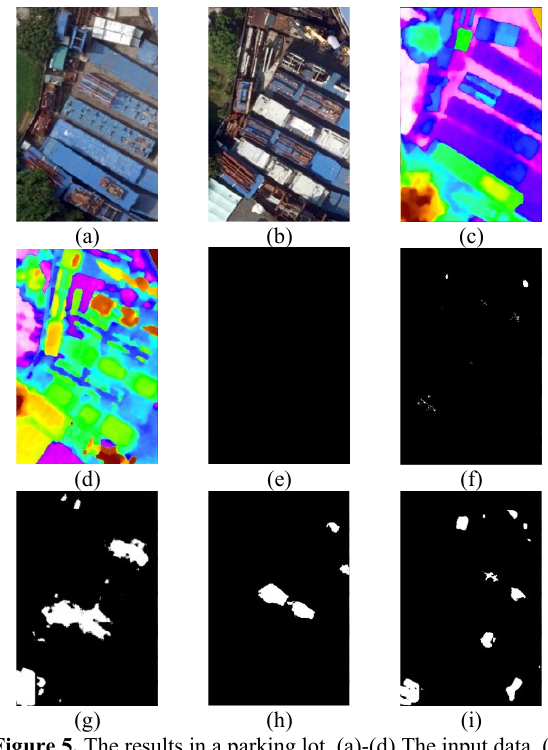
Figure 5. The results in a parking lot. (a)-(d) The input data. (e) Ground truth. The change maps of (f) ours, (g) CDNet, (h) MFPNet, and (i)